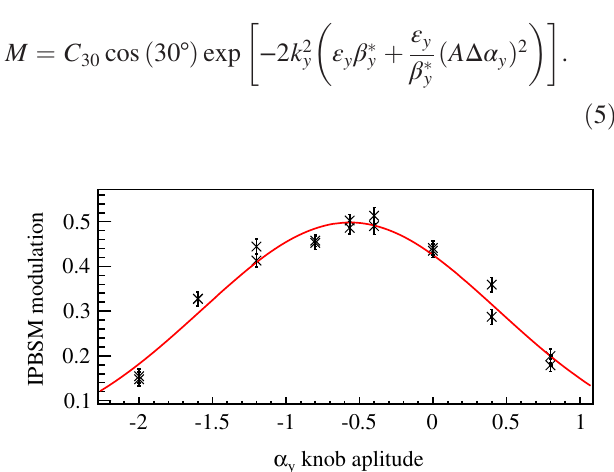
FIG. 4. Shintake monitor schematic design. The electron beam interacts with a transverse interference pattern generated by two crossing laser beams. The number of scattered photons varies with the fringe size and the particle beam size [6].